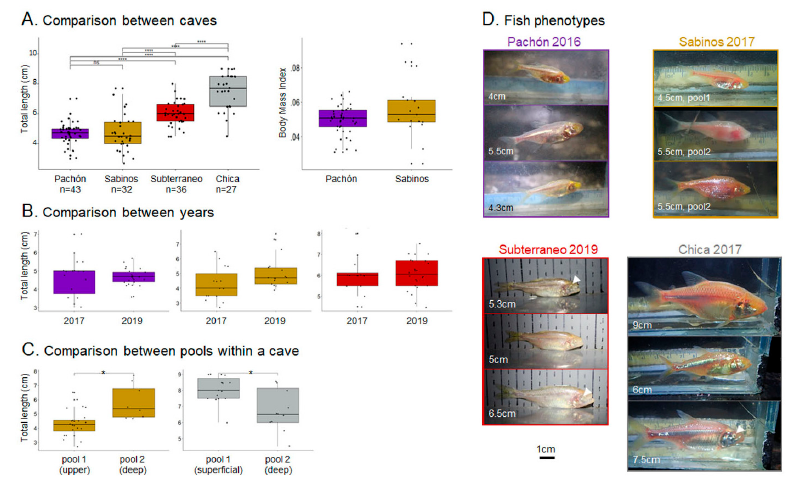
Figure 4. Sampling cavefish olfactory skills in their natural environment; ( A ) Simplified map of the Figure 4. Cavefish sizes and phenotypes in different caves; ( A ) Sizes (left graph) and body mass region of Ciudad Valles, Mexico. Mountain ranges are in grey. The locations of visited caves are indexes (BMI, right graph) of the cavefish individuals tested for olfactory responses in the Pachón (purple), Sabinos (brown), Subterráneo (red), and Chica (grey) caves. Asterisks indicate significant indicated by colored circles. The color code indicates the geographical group where they belong; differences (Mann–Whitney test); ( B ) Comparison of sizes of the cavefish tested for olfactory ( B ) Fieldwork in the Pach ó n cave. The main pool was muddy and the water level was low. Note that in responses in different field campaigns, in 2017 and 2019, showing that the condition of the fish tested March 2017 and March 2019, the three plastic pools were installed and processed in the best possible did not vary; ( C ) Comparison of sizes of cavefish in different water ponds in a same cave locality, showing that fish condition varied, probably due to local trophic, environmental and/or genetic reproductive manner, on the “beach” along the main pool. Close-ups show the Luer-lock perfusion parameters; ( D ) Fish phenotypes are fully troglomorphic in the Pachón and Sabinos caves, whereas system and the eight fish installed in one of the experimental plastic pools; ( C ) Work in pool 2 of the hybrid-type fish with small eyes (arrowheads) and some pigmentation can be seen in Subterraneo Subterr á neo cave, located just after the 3-m pit. This pool o ff ers a rocky substrate. There, we repeatedly (pool 2) and Chica (superficial pool) caves. They result from hybridization with introgressed surface fish. Of note, in Subterraneo, surface fish enter by the cave entrance at the polje level, whereas, in observed the presence of crayfishes (predators on adult cavefish). The bottom right panel shows the Chica, surface fish enter the cave by the bottom. Hence, in both caves, the most troglomorphic fish infrared, hunting-type camera, used in our 2019 campaign; ( D ) Work in Los Sabinos cave. Pool 1 of are larger. this cave had crystal-clear water. Again, note that olfactory setups were installed in the same place in March 2017 and 2019, respectively, i.e., on a rocky plateau just above pool 1. A close-up shows the Raspberry Pi camera used during our 2017 campaign. ( E ) Testing olfaction on fish from the Chica superficial pool. The top photos show the guano slope leading to the superficial pool, which was very rich in organic material (decomposing bat cadaver). On the bottom left panel, note the large size of the eight fish (compare with the equivalent picture in Pach ó n, and see Figure 3). Diversity 2020 , 12 , x FOR PEER REVIEW